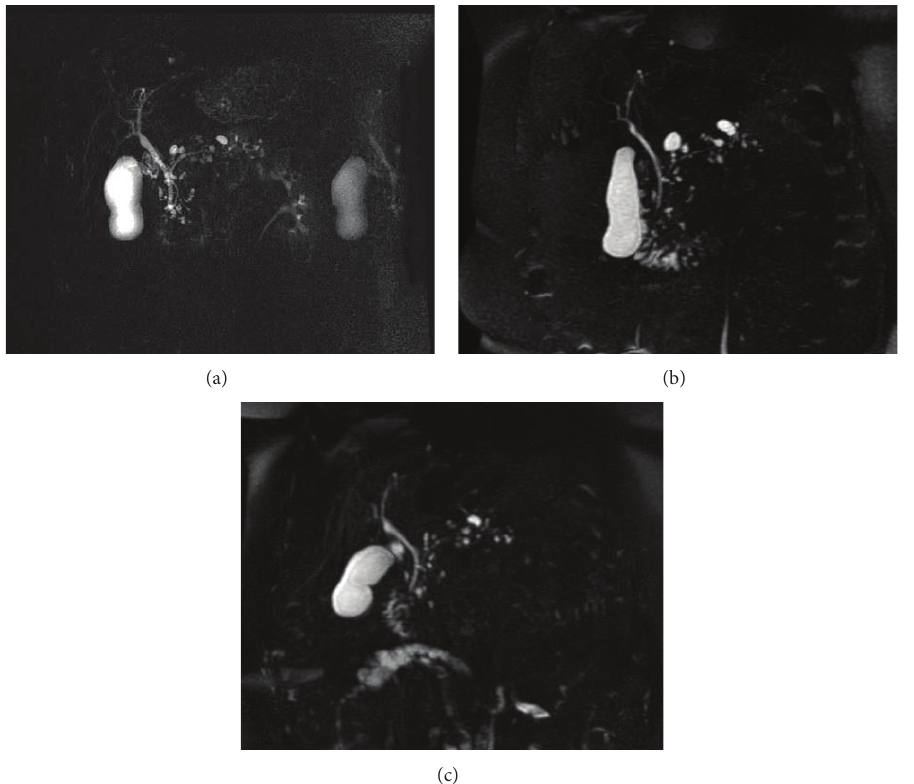
Figure 6: Coronal MRCP acquisitions in an asymptomatic 70-year-old female patient with an incidental radiological finding of multiple pancreatic cystic lesions; MRCP exams were performed in 2009 (a), in 2012 (b), and in 2013 (c). Multiple small cystic lesions in the pancreatic parenchyma are clearly depicted in the three MRCP acquisitions, some of them showing a typical connection to the main pancreatic duct. This typical radiological pattern suggests the diagnosis of multifocal BD-IPMNs. No main pancreatic duct dilatation is observed. Cystic lesions do not show intraluminal solid components or mural nodules. Over time the MRI monitoring initially showed a mild enlargement of the lesions (from a to b) and then a size-reduction (from b to c). As reported in literature, IPMNs in a multifocal setting could also be managed in a safe and reliable